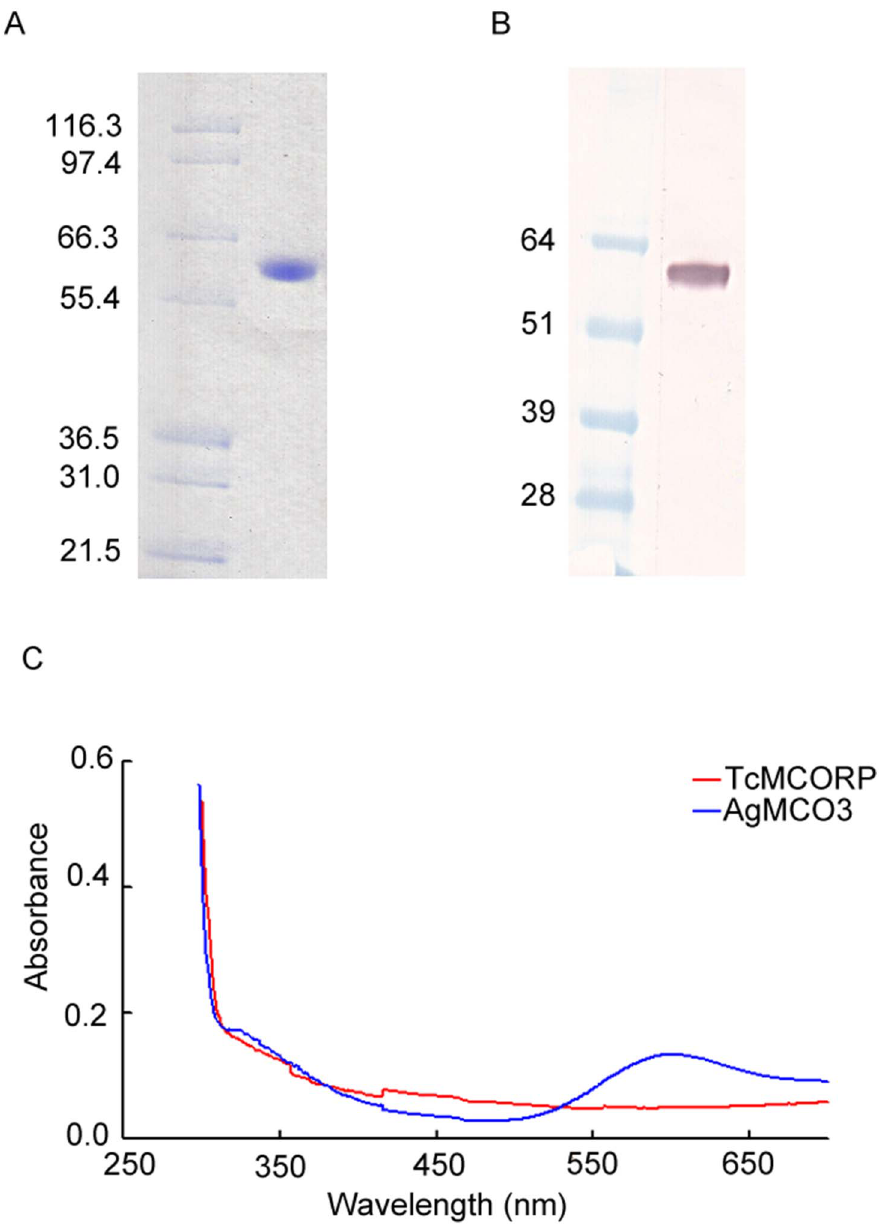
Figure 4. SDS-PAGE, immunoblot analysis and absorption spectrum of purified TcMCORP. A) Purity was verified by Coomassie staining. B) The identity of the purified protein was confirmed by immunoblot analysis using antiserum against TcMCORP. C) UV/vis spectra of purified